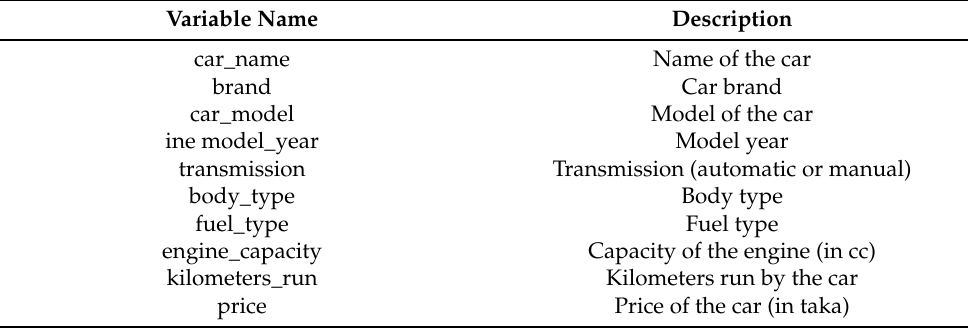
Table 1. Description of selected attributes.